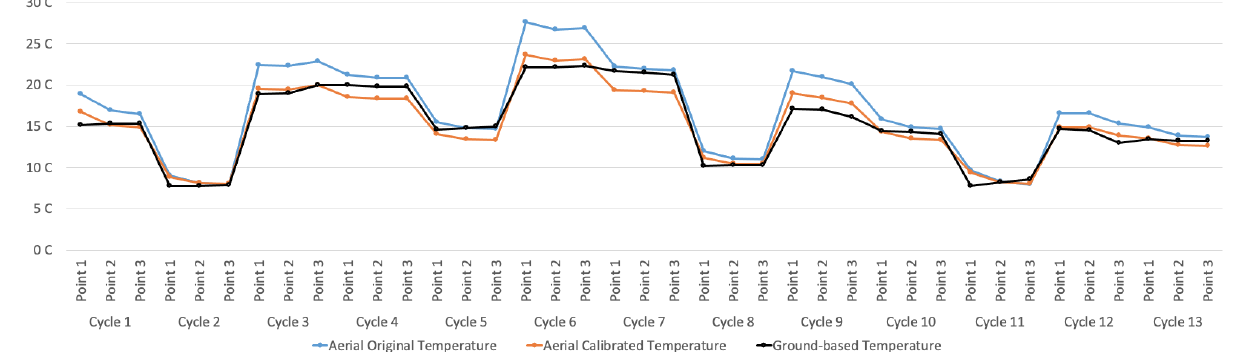
Figure 13. Original and calibrated aerial temperature data compared with ground-based data.